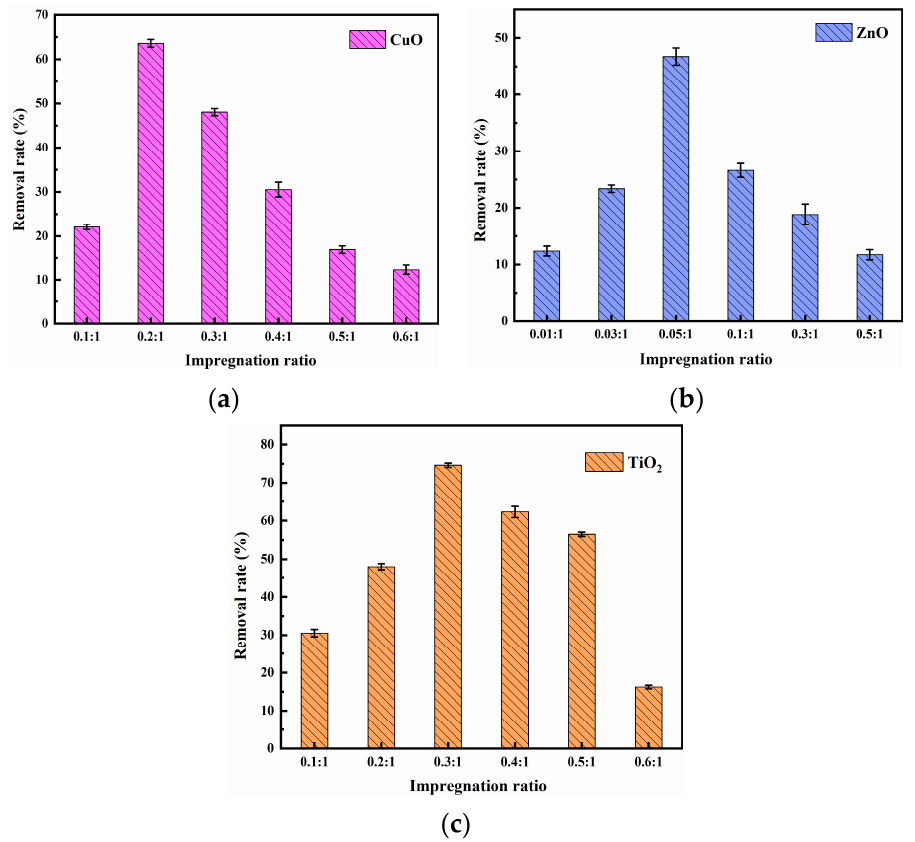
Figure 2. Effect of ( a ) CuO; ( b ) ZnO; ( c ) TiO 2 composite materials’ impregnation ratio on methylene blue removal (impregnation time (CuO) = 70 min, impregnation time (ZnO) = 50 min, impregnation time (TiO 2 ) = 50 min, initial methylene blue concentration = 5 mg/L, composite materials dosage = 1 g/L, contact time = 60 min, temperature = 25 ± 0.5 °C, initial pH = 7.00).